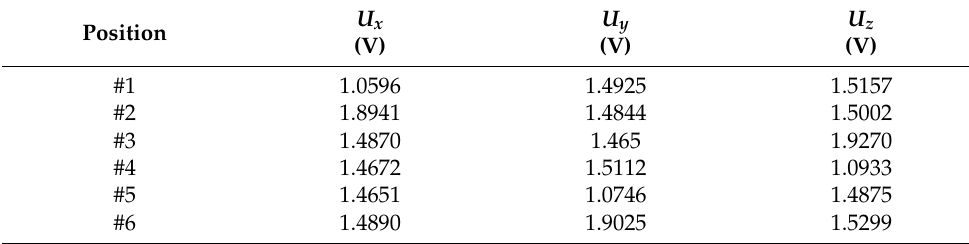
Table 5. Averaged values of the output voltages six hours after the start-up.